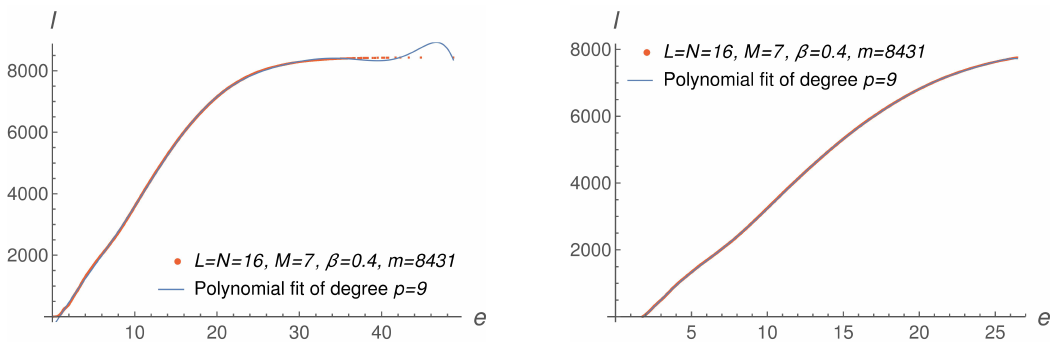
Figure 9: Plot of n ( e ) for the β -deformed theory and a polynomial fit of degree 9. On the left we fit the whole spectrum, but obtain poor behaviour for extreme values of e . On the right we clip 4% of the states at each end, and find that the fit captures n more av